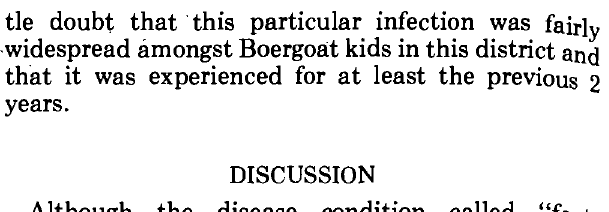
Table 1: BACTERIOLOGICAL ISOLATIONS FROM THE ULCERATIVE LESION OF FIVE BOERGOAT KIDS Isolate Case No. Anaerobic